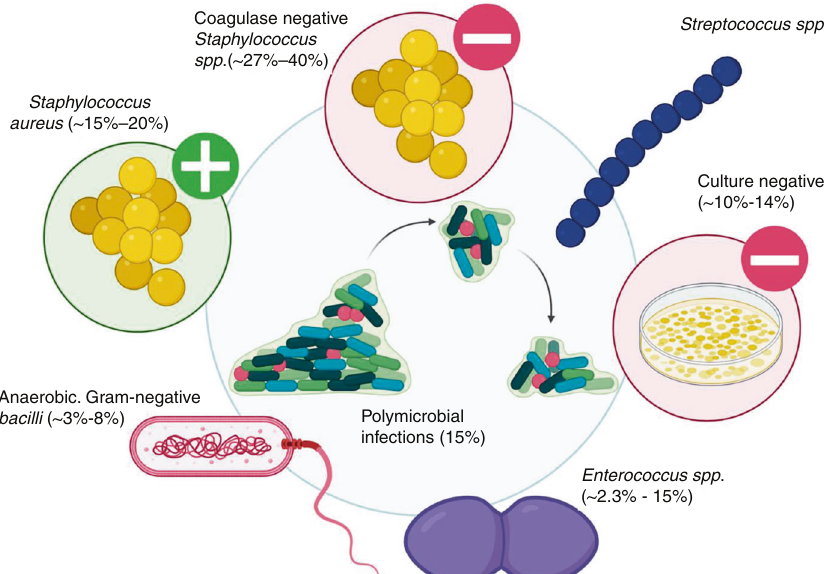
Fig. 1 A schematic presenting examples of the various pathogens associated with orthopedic PJIs and their estimated incidence. 34,36,37 Mono- and polymicrobial infections are associated with PJI, with up to 15% of all cases being comprised of multiple bacterial species ( spp .). Staphylococcus and coagulase-negative staphylococci are involved in 50% – 60% of